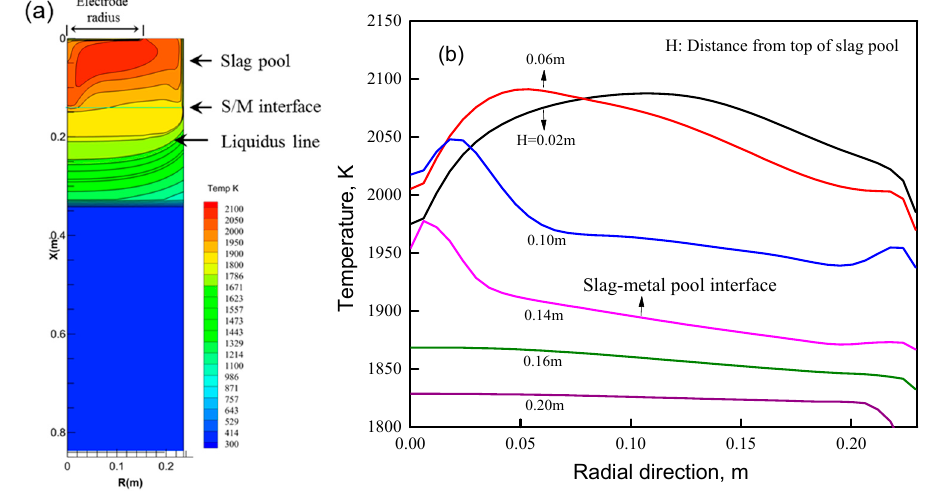
Figure 4. Temperature distribution of slag pool and metal pool.